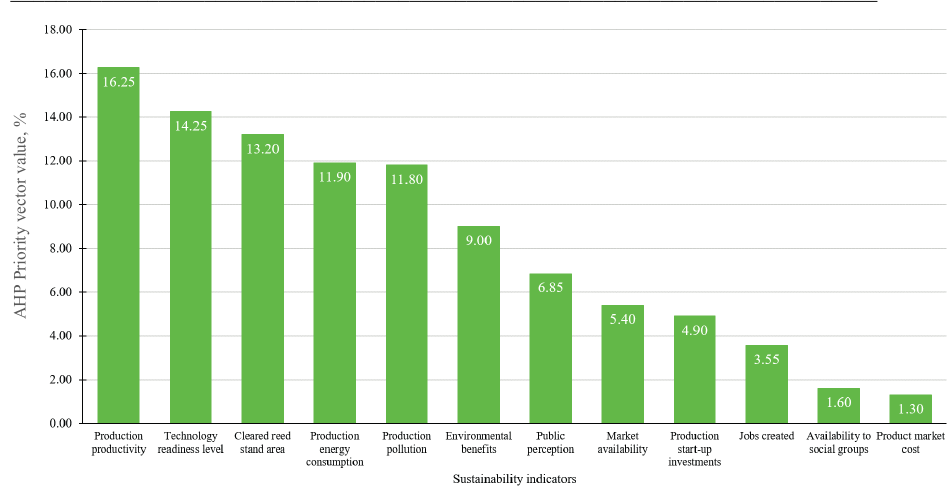
Fig. 4. TOPSIS indicator weight values after AHP calculations.